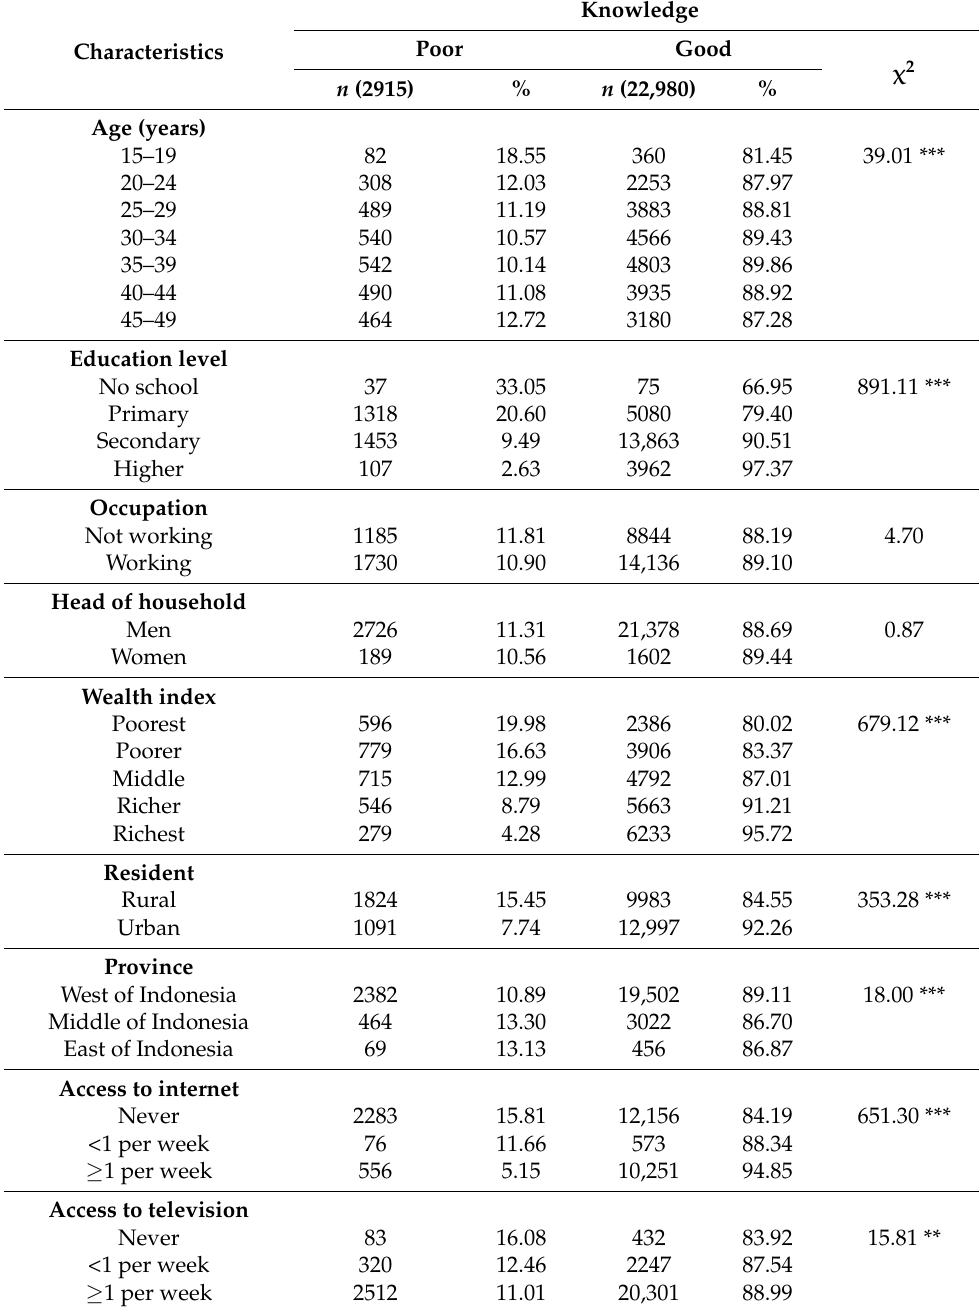
Table 2. Socioeconomic and demographic information and knowledge toward HIV/AIDS among women aged 15–49 years old in